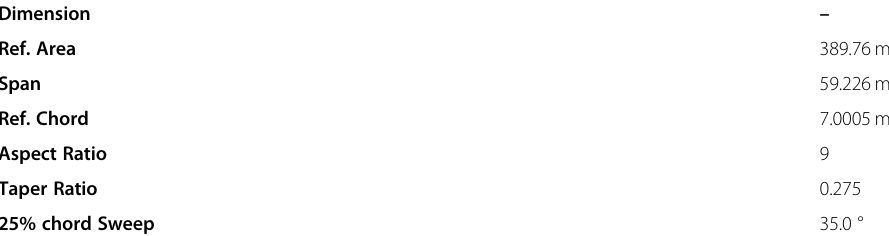
Table 1 Geometrical dimensions of the NASA CRM CFD model Dimension – Ref.